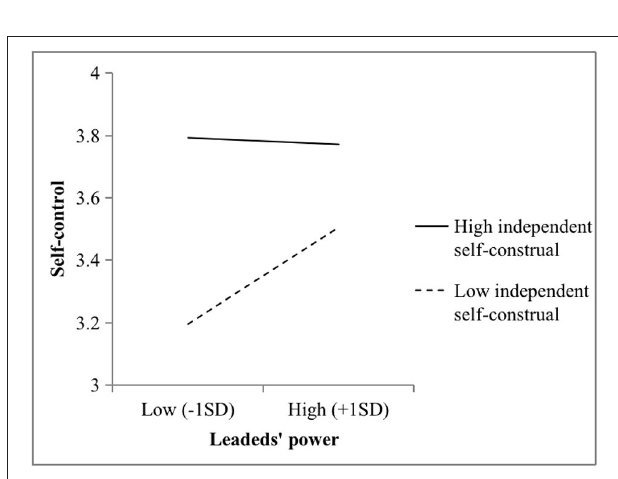
FIGURE 5 | Two-way interaction effect between the power and independent self-construals of leaders on self-control in Study